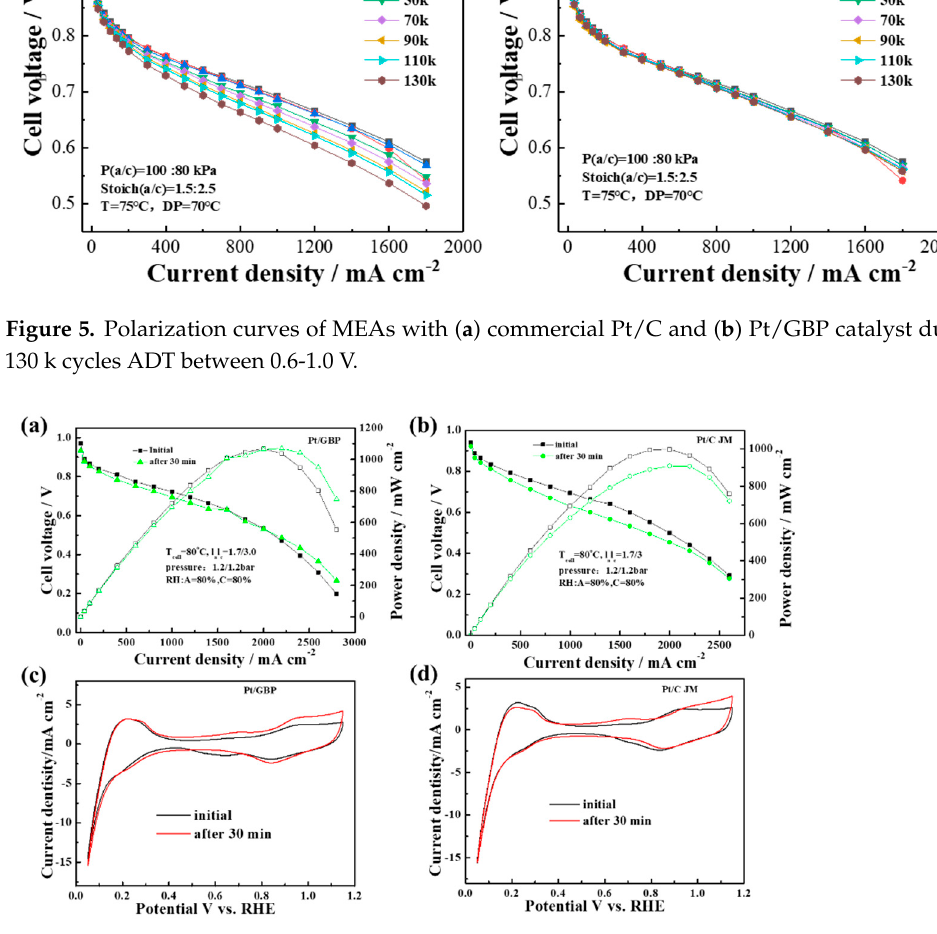
Figure 6. ( a , c ) The polarization curves and CV curves of Pt/GBP before and after ADT at 1.5 V for 1800 s; and ( b , d ) The polarization curves and CV curves of commercial Pt/C before and after ADT at 1.5 V for 1800